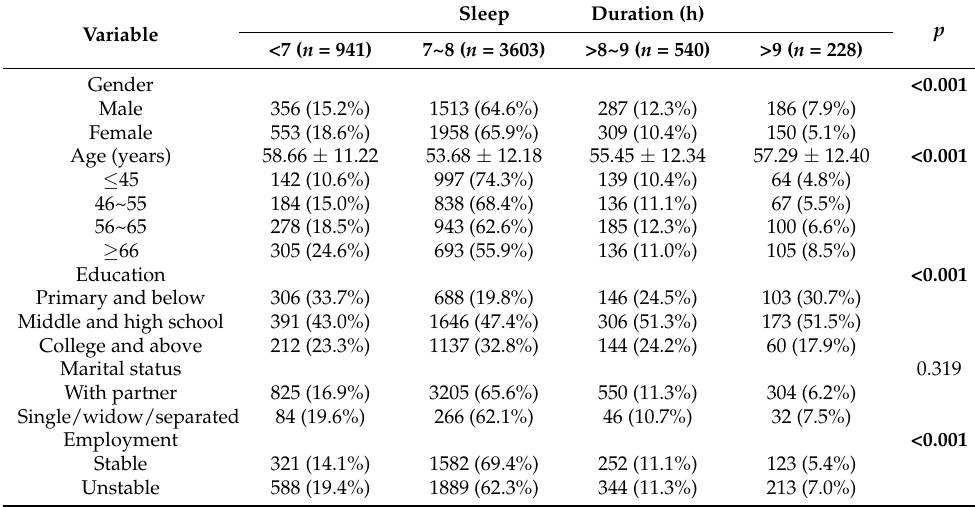
Table 1. Sociodemographic characteristics across categories of average sleep